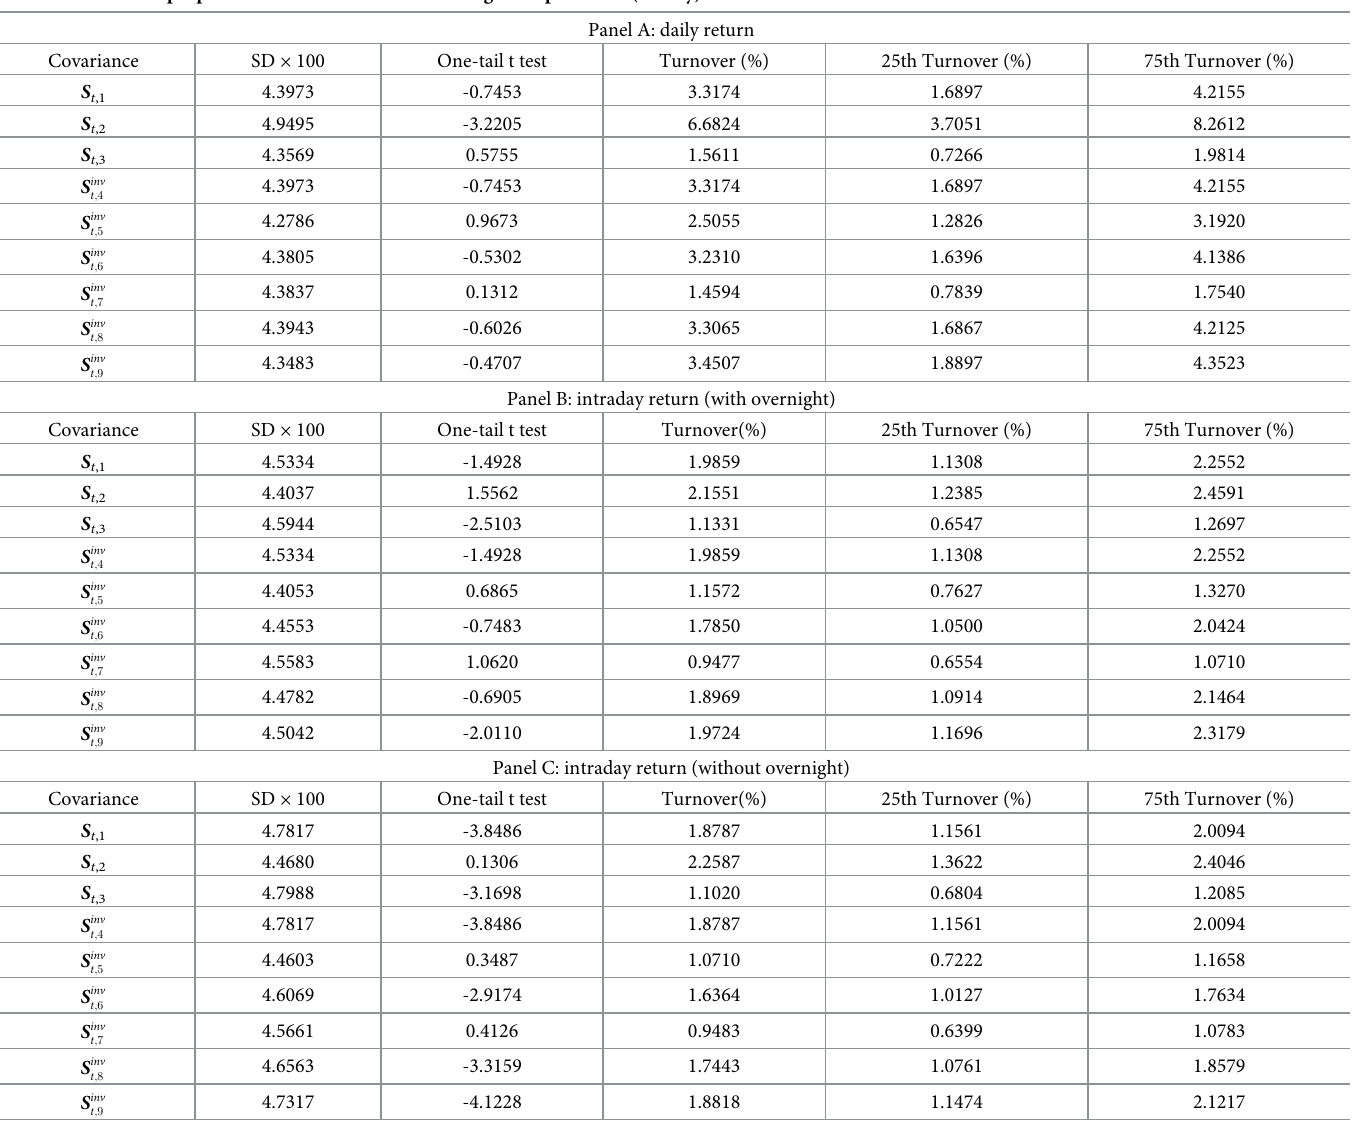
Table 6. Out-of-sample performances of minimum tracking error portfolios (T = 1 y).